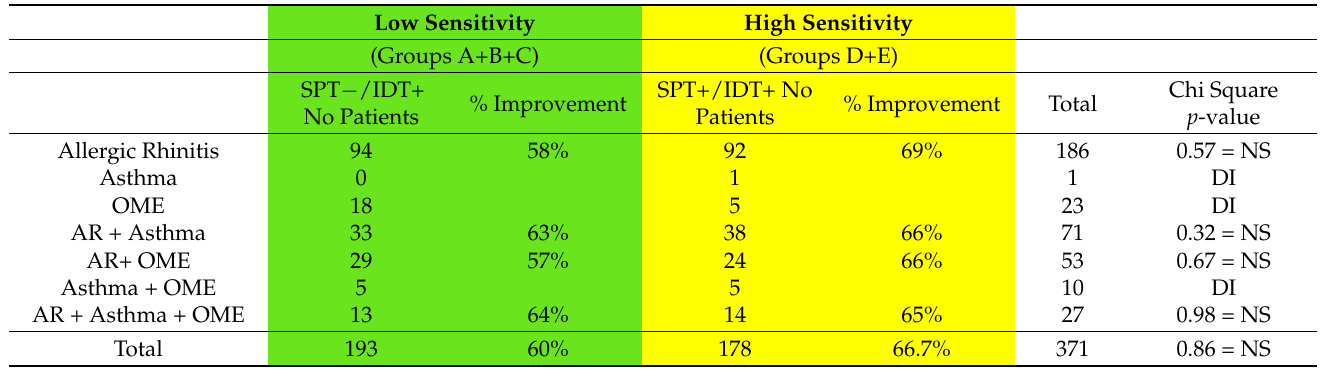
Table 4. Comparison of symptom improvement by allergen sensitivity and by type of allergic